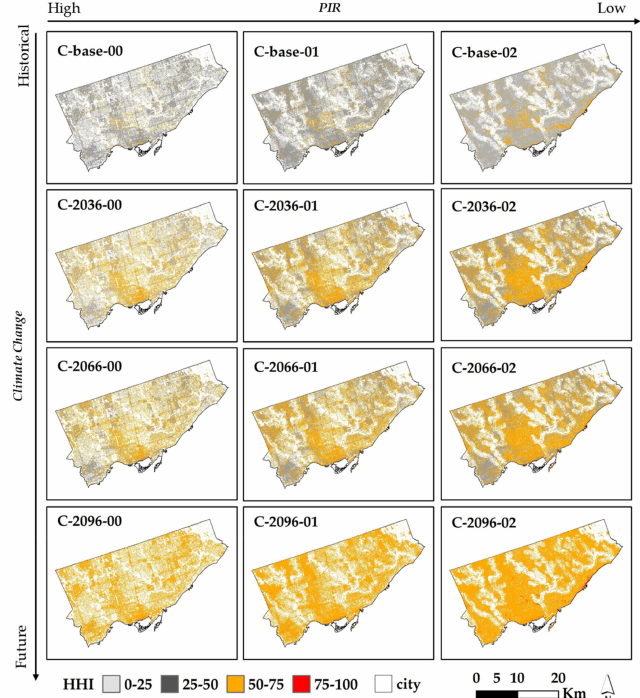
Figure 5. The HHI maps for Toronto under di ff erent climate (base year, 2036, 2066, and 2096) and land cover scenarios (base, Scenario 1, and Scenario 2).